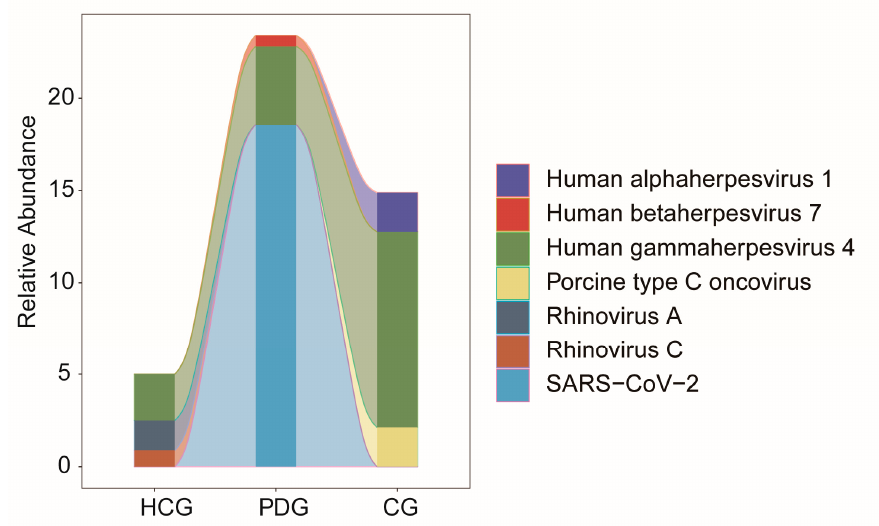
Figure 3. Oropharyngeal viral alterations among HCG, PDG and CG. The relative abundance changes of 7 oropharyngeal viral species (including SARS-CoV-2) among HCG, PDG and CG. HCG: healthy control group. PDG: period of disease group. CG: convalescent group.